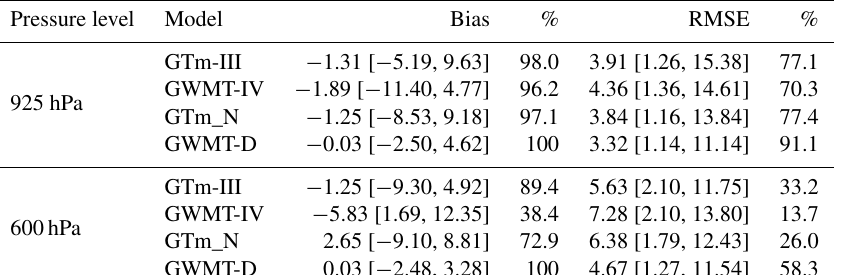
Table 3. The globally mean biases and RMSEs of the differences between the T m (in K) derived from four empirical models and 2014 NCEP2 data on pressure levels of 925 and 600hPa. Values within square brackets are the minimum and maximum, and the % column is the percentage of those global grids with a value ≤ 5K.